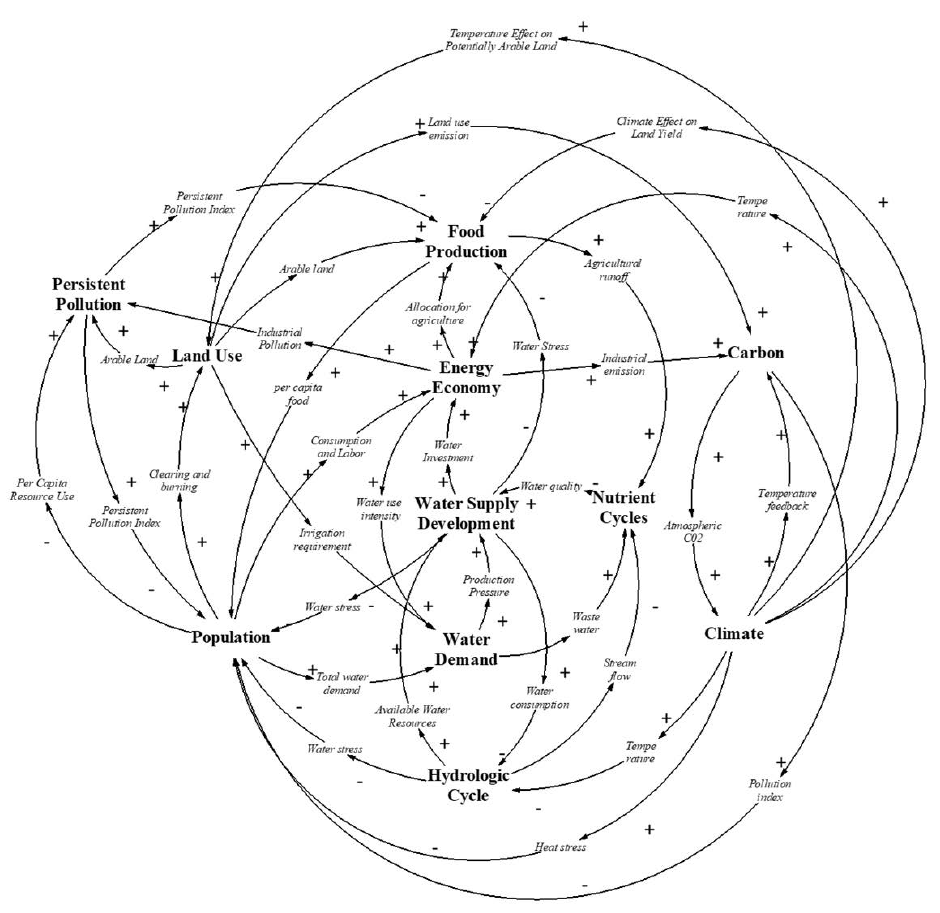
Figure 1. High-level feedback structure of the ANEMI3 model illustrated as a causal loop diagram ( + signs along causal relationships indicate change of connected variables in the same direction; − sign indicates change in opposite